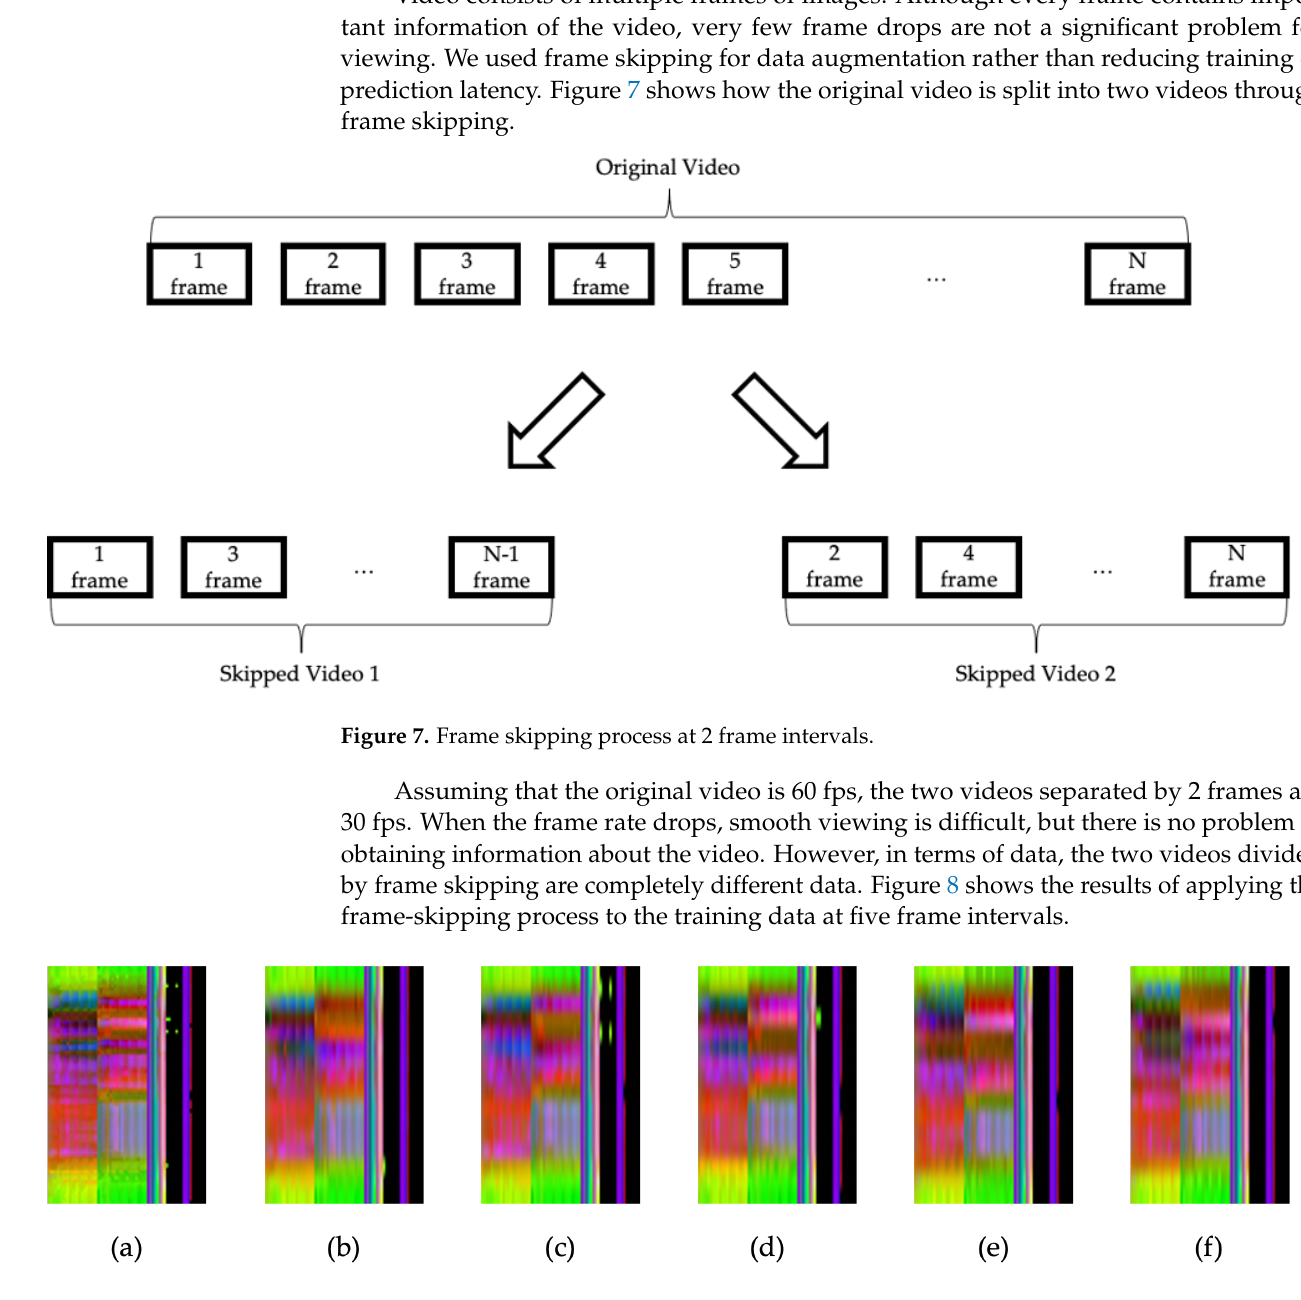
Figure 8. Result of frame skipping at 5 frame intervals; ( a ) original data; ( b – f ) frame skipped